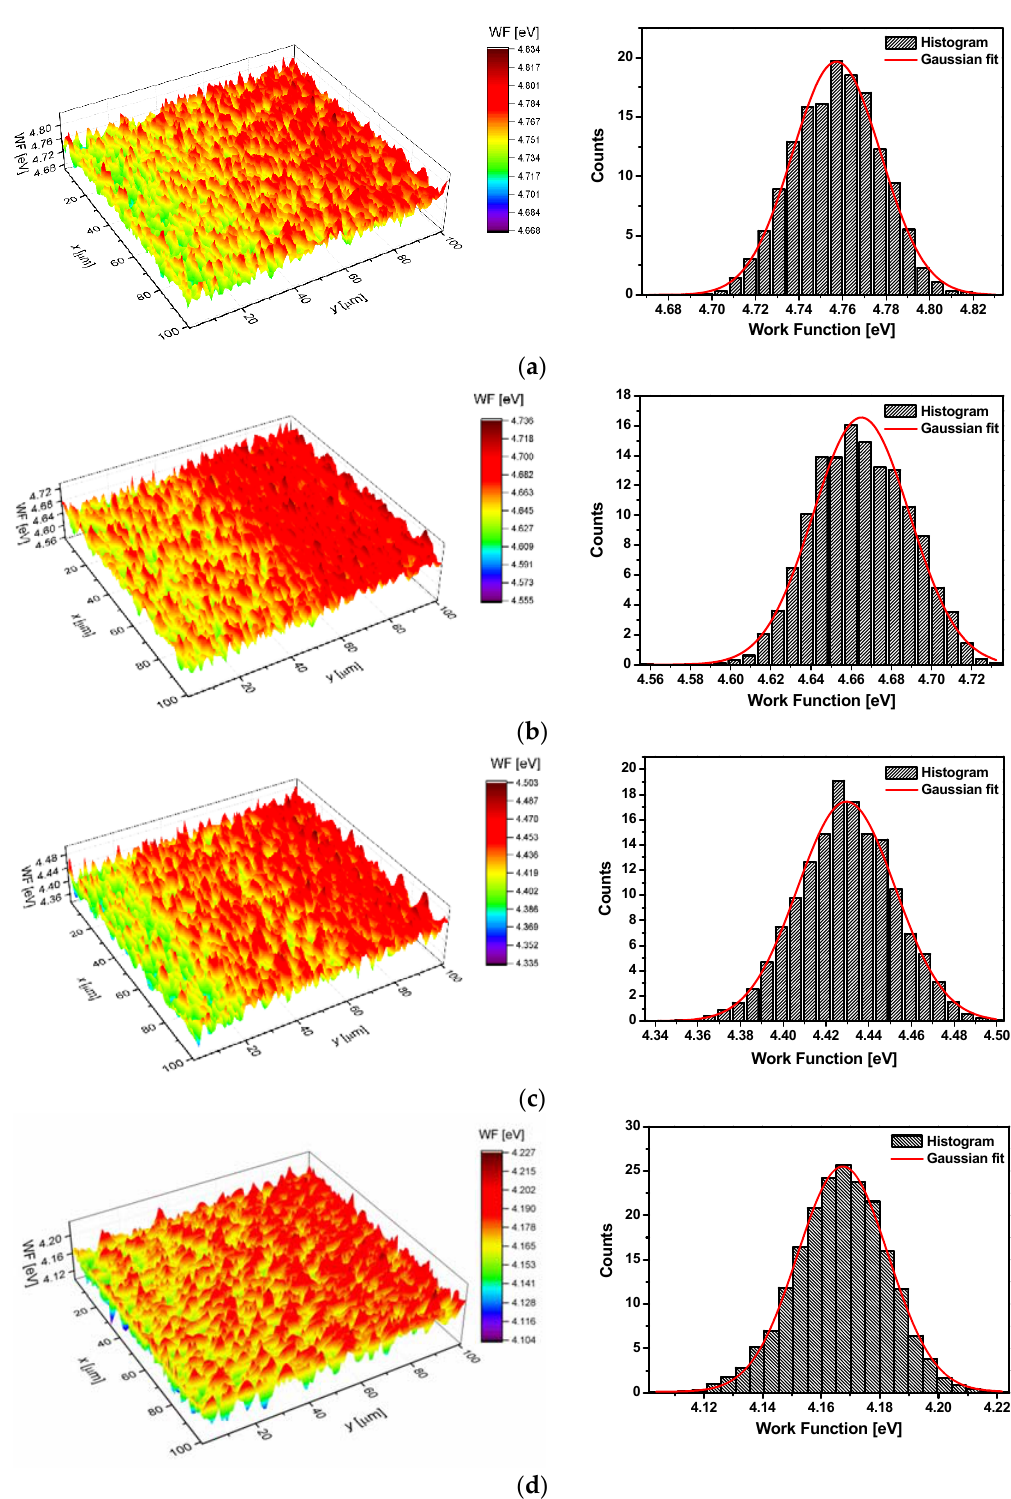
Figure 11. A surface distribution map of the work function for the Pd 80 Rh 20 alloy before and after hydrogen electrosorption with the corresponding work function distribution histogram and Gaussian fitting curve: ( a ) Pd 80 Rh 20 alloy; ( b ) α Pd 80 Rh 20 H; ( c ) α - β Pd 80 Rh 20 H; ( d ) β Pd 80 Rh 20